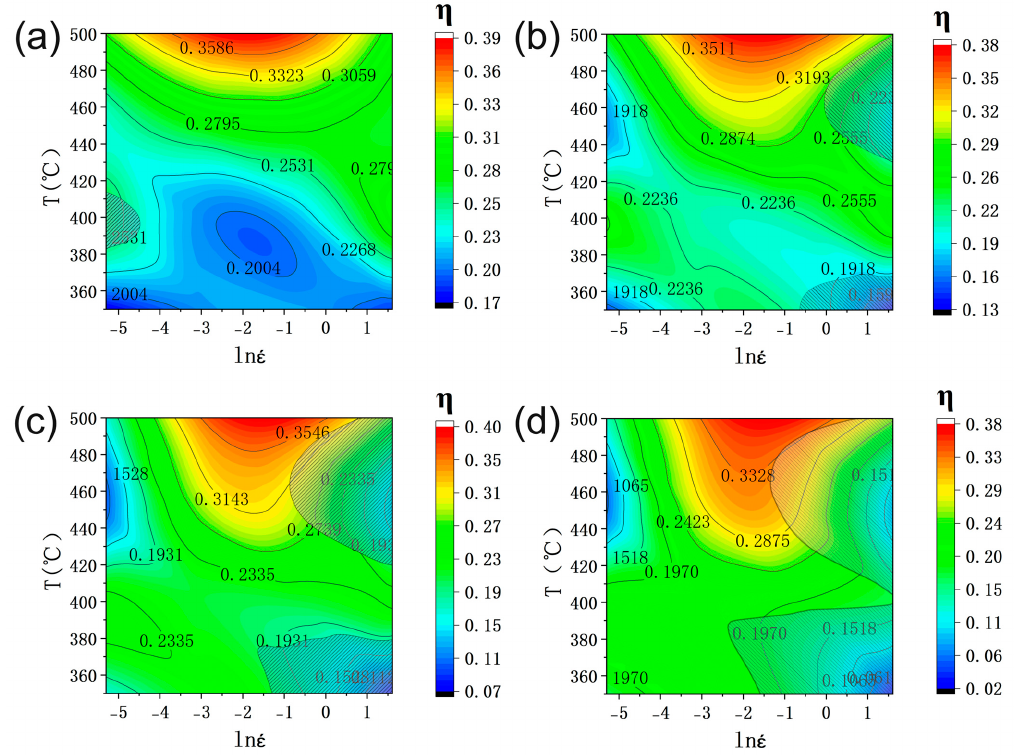
Figure 6. DMM processing maps of the SiCp/6013 composites at different strain levels: ( a ) ε = 0.1, ( b ) ε = 0.3, ( c ) ε = 0.5, ( d ) ε = 0.7.